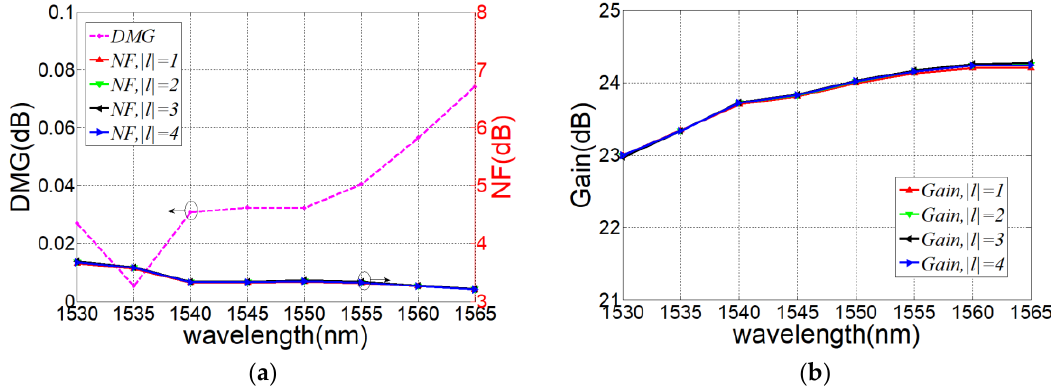
Figure 6. ( a ) DMG and NF versus wavelength; ( b ) Gain versus wavelength.